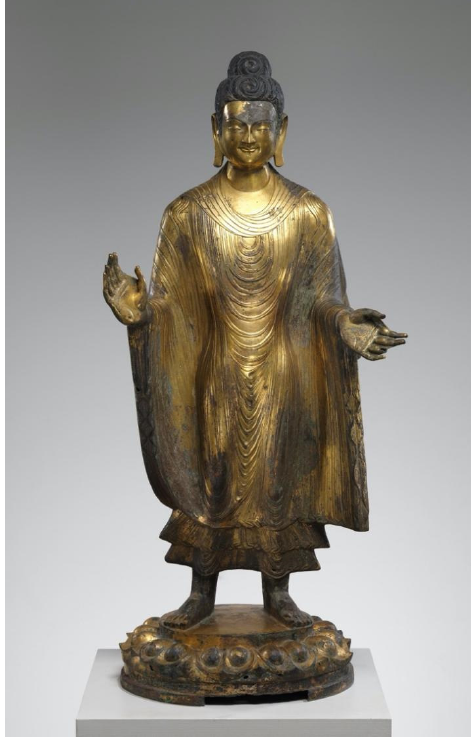
Figure 6. Gilded bronze Buddha Maitreya from the Northern Wei Dynasty, 10th year of Taihe reign. Materials: gilt bronze. Dimensions: H. 140.3 cm × W. 62.2 cm × D. 48.9 cm. Displayed in the Metropolitan Museum of Art, New York, United States of America. Photo source: the official web- site of the Metropolitan Museum of Art (Strahan and Strahan 2010, p. 59).